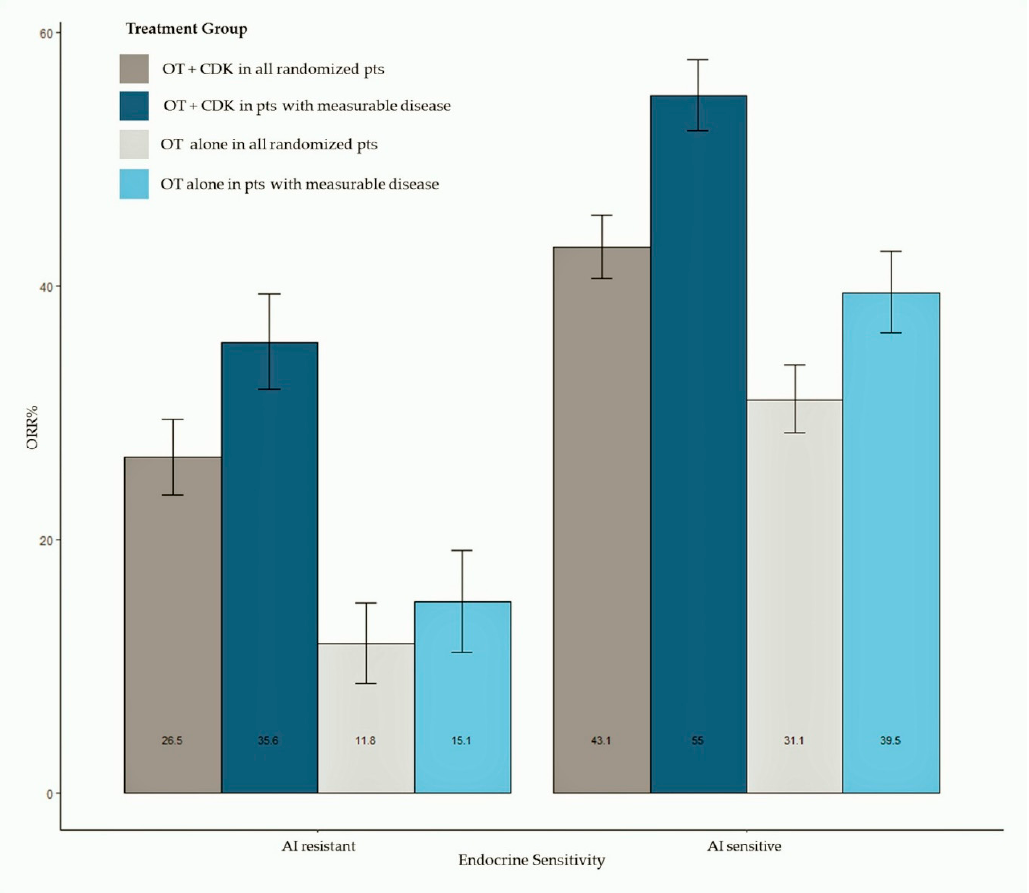
Figure 3. Bar plot of pooled ORR in all randomly assigned patients and in patients with measurable disease according to ET sensitivity status. Abbreviations: ORR: objective response rate; OT: hormonal therapy; CDK: cyclin dependent kinase).